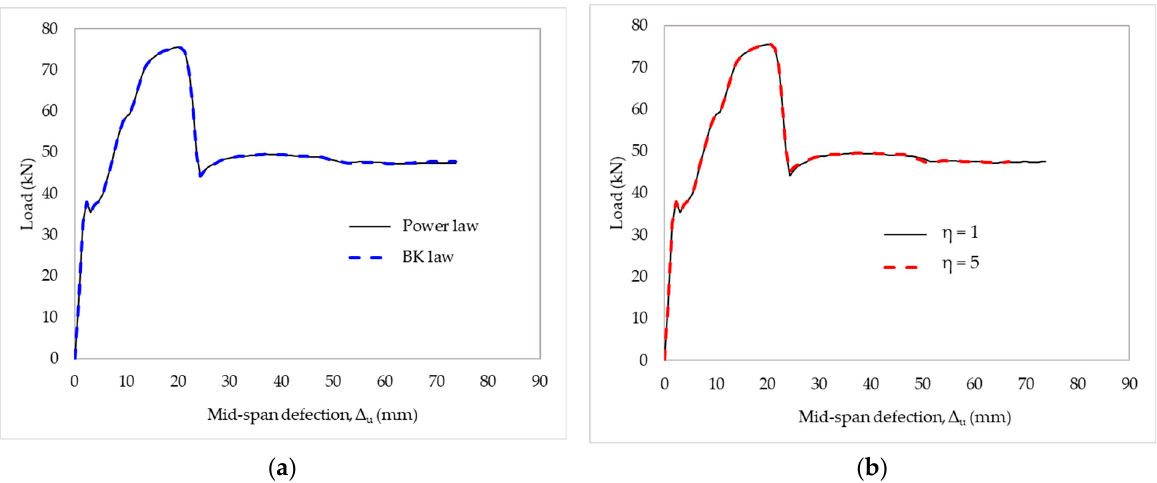
Figure 16. The effects of strengthened slabs on damage evolution: the criteria of ( a ) mixed-mode failure and ( b ) cohesive parameter ( η ).